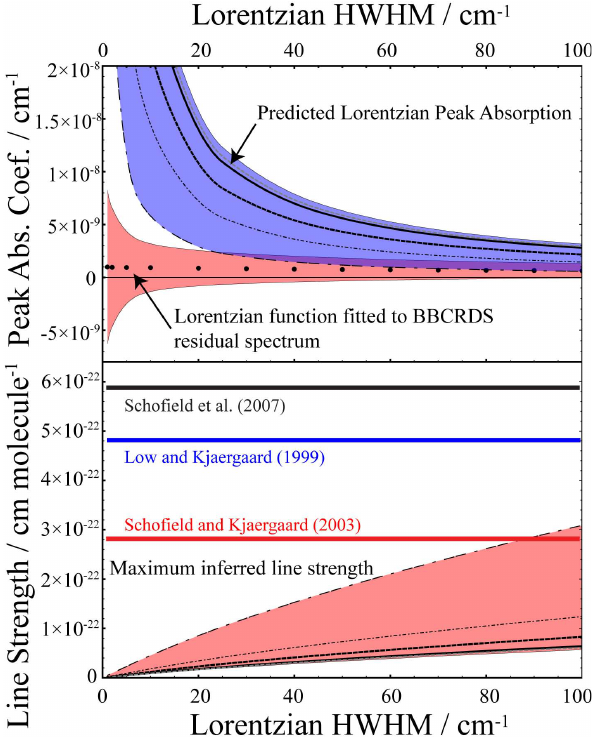
Fig. 9. Upper panel: an analogous plot to Fig. 8 for the average in- tensity of Lorentzian functions fitted to the BBCRDS residual spec- trum in 2cm − 1 intervals across the full measurement bandwidth. The predicted peak absorption (blue envelope enclosing the vari- ous K eq ( T ) values) was calculated using the smallest dimer band intensity from theory: S =2.83 × 10 − 22 cmmolecule − 1 (Schofield and Kjaergaard, 2003). Lower panel: upper limits on the dimer line strengths consistent with the BBCRDS residuals calculated as a function of Lorentzian HWHM (using black dots data from the upper panel) for the different literature values of K eq (lines in pink regions). Line strengths from the theoretical studies are shown as the heavy horizontal